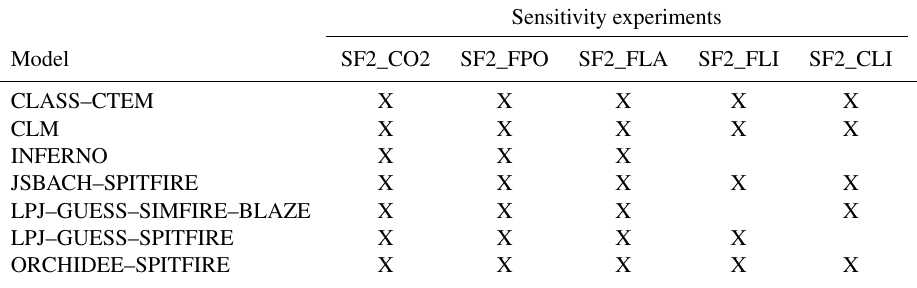
Table 2. Sensitivity experiments conducted by FireMIP